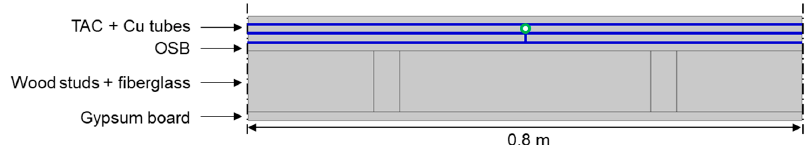
Figure 6. Simplified 2D COMSOL model used for annual simulation with symmetric boundary conditions at the two edges.